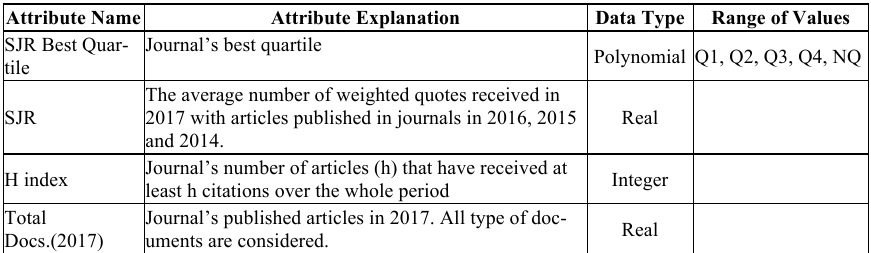
Table 1. List of attributes in the